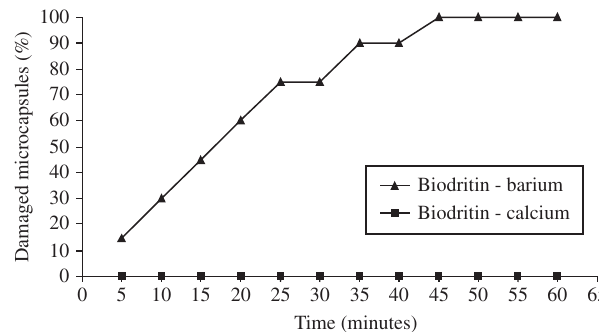
Figure 2. Variation in the number of damaged microcapsules after being subjected to rotational stress. The microcapsules were counted in each five minutes during the experiments using optical microscope.